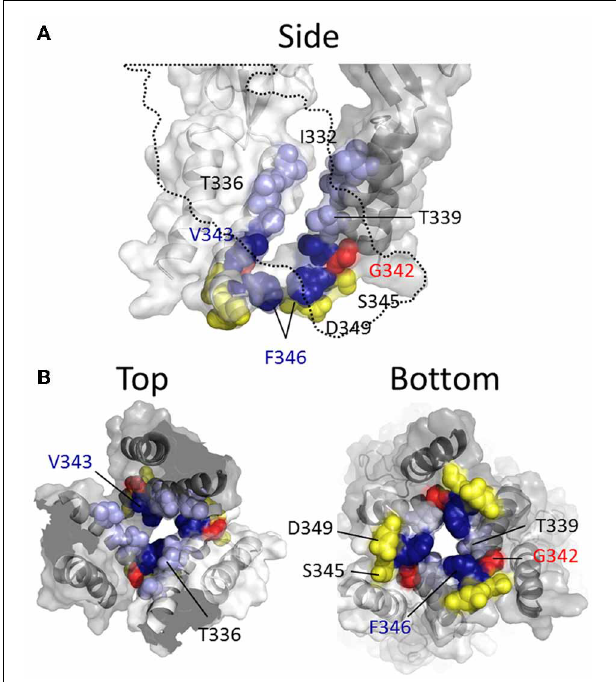
FIGURE 5 | Mapping P2X2R TM2 substituted cysteine side chains capable of coordinating Cd 2 + in the open channel state. Side chains at which cysteine substitution renders the mutant receptor sensitive to current modification by Cd 2 + applied in the presence of ATP are shown as ball models. (A) Side view of TM domains with third subunit omitted for clarity (dotted line). (B) TM domains viewed from extracellular (left panel) and intracellular perspectives (right panel). Color coordination is as follows: Light blue,mutantcurrentsreversiblyinhibitedbyCd 2 + ;Darkblue,mutantcurrents irreversibly inhibited by Cd 2 + ; Yellow, mutant currents irreversibly modified due to Cd 2 + coordination between introduced Cys side chain and native amino acid side chains; Red, mutant currents reversibly potentiated by Cd 2 +